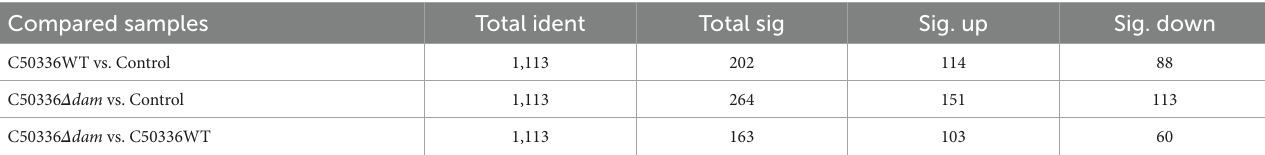
TABLE 1 Metabolite difference analysis.